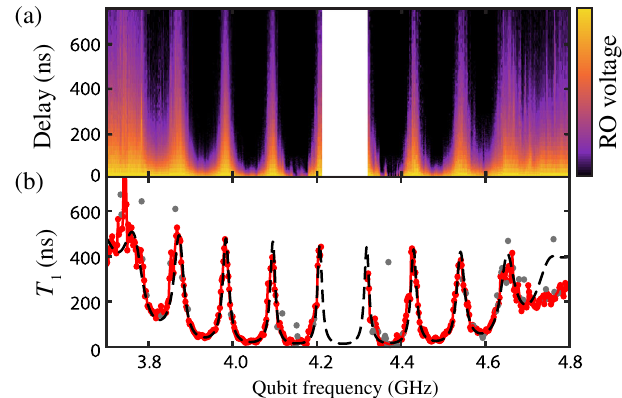
FIG. 7. Qubit spontaneous emission. (a) Each measured qubit T 1 decay is shown normalized by its maximum value. (b) The extracted T 1 times match the model for the qubit-phonon emission rate. A small fraction of decays displayed nonexpo- nential features with timescales inconsistent with the intra-IDT delay time (gray).